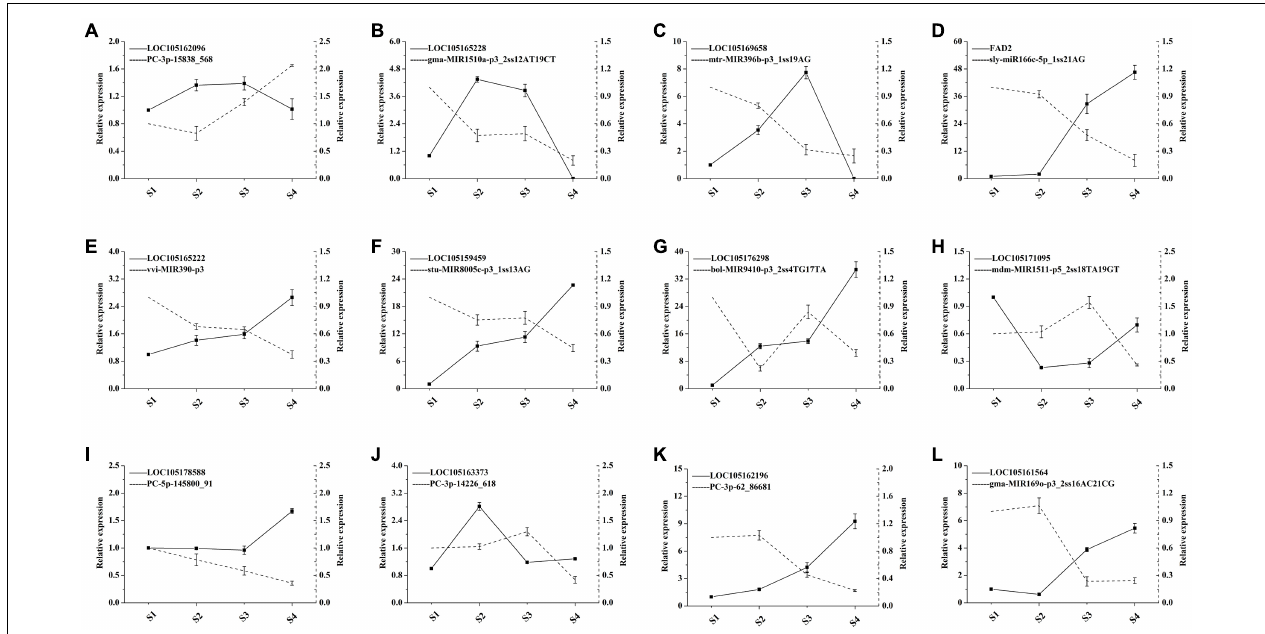
FIGURE 7 | qRT-PCR validation of miRNAs and their target expression correlation in different development periods of sesame seed ( n = 3). The dotted and solid lines express miRNAs and target genes, respectively.